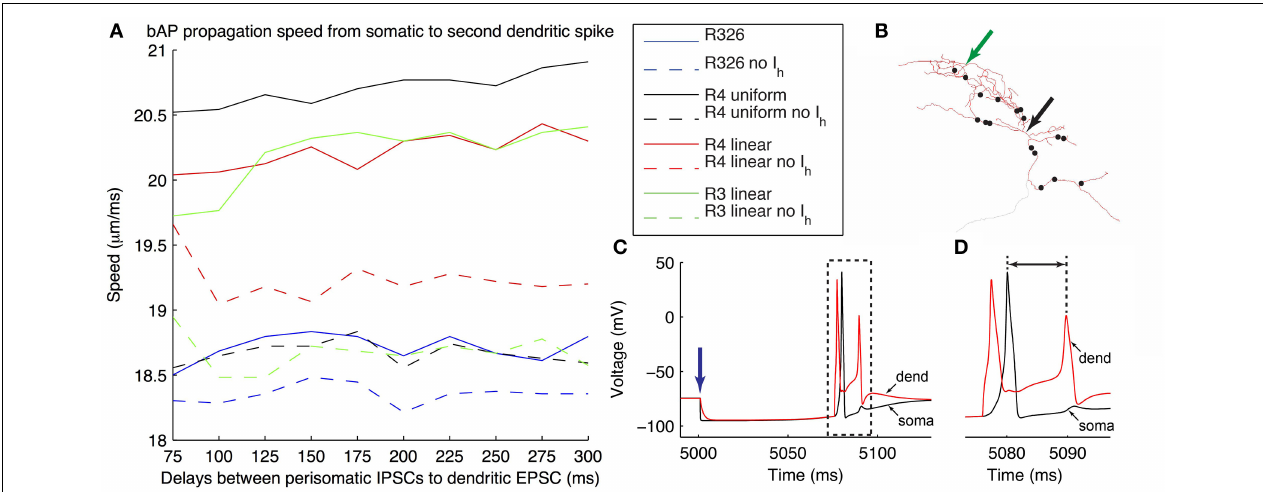
FIGURE 10 | Illustration of generation of back-propagating action potentials in O-LM model in response to inhibitory MS-DBB-like inputs and excitatory inputs. (A) Speed of back-propagating action potential (bAP) measured in the model in response to different delays between the initial inhibitory post-synaptic current activation (IPSCs) and subsequent excitatory post-synaptic current activation (EPSCs). Several models are shown, including somatic I h only (R326). In all cases, bAP speeds are also shown in the case with I h currents blocked. (B) Locations of MS-DBB-like IPSC inputs